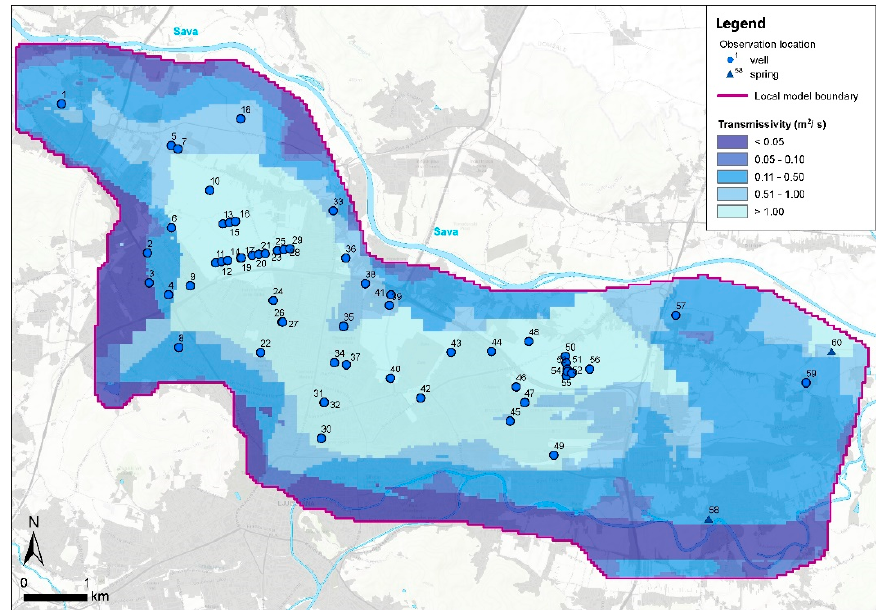
Figure 1. Map of the study area showing observation locations, groundwater level isolines, model boundaries, artificial surfaces, and well fields.